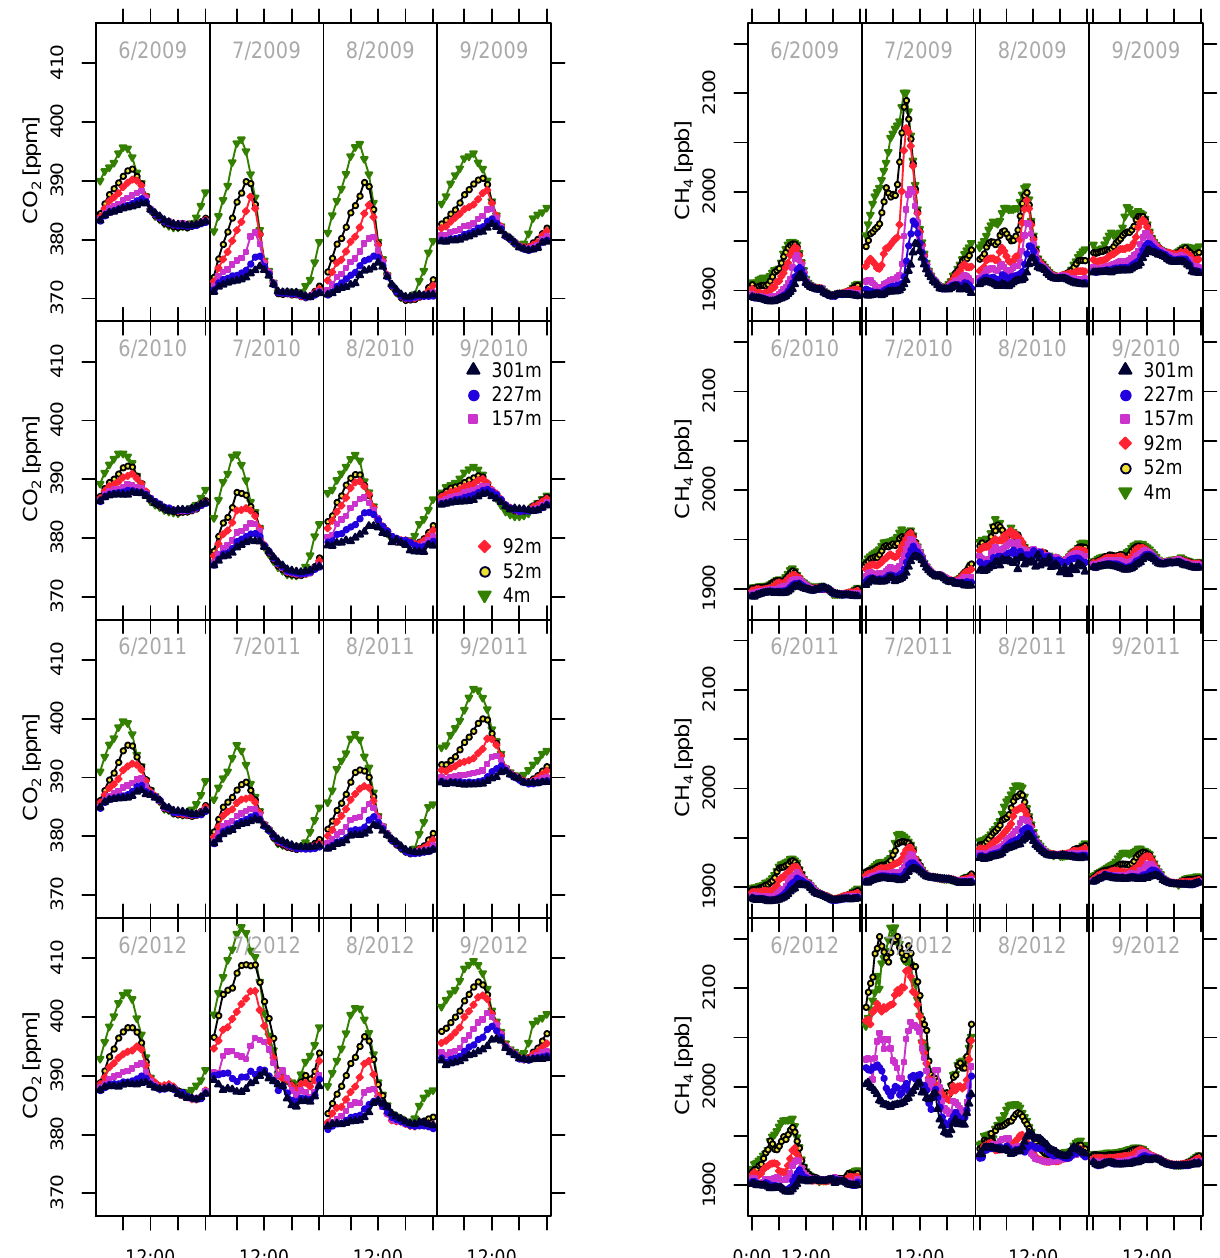
The capping nighttime inversion causes an amplitude in the nocturnal CO 2 signal at ZOTTO (Fig. 3) that is compa- rable to the one measured at other tall towers, for example in Europe (Popa et al., 2010; Vermeulen et al., 2011). In con- trast, CH 4 has a more intense diurnal cycle at ZOTTO than a European rural site (Popa et al., 2010); larger contributions are also expected from the Siberian wetlands.